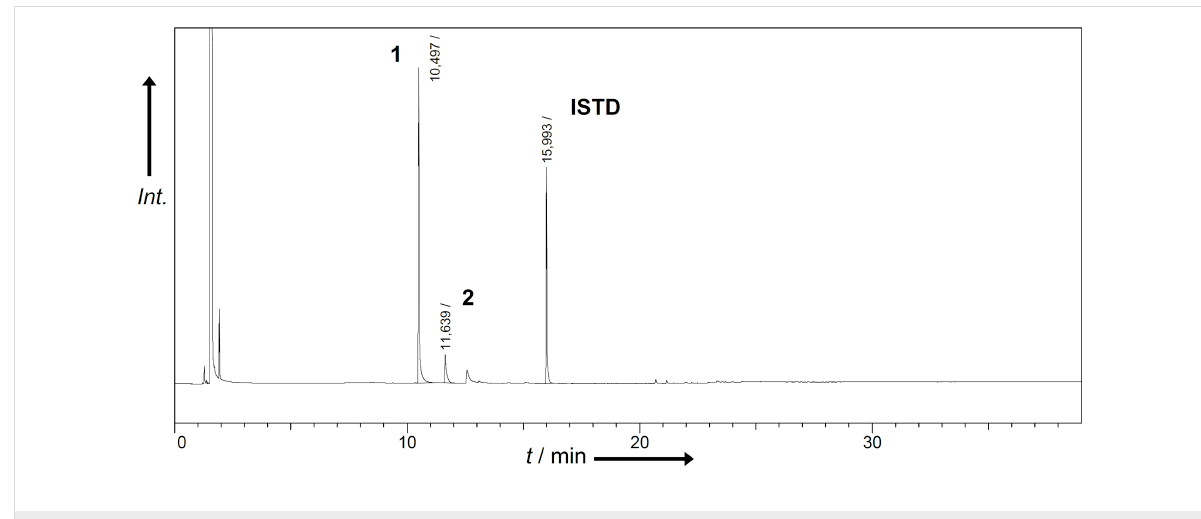
Figure 1: Crude product composition after electrochemical treatment of lignin at Ni-based electrodes by gaschromatography. Retention times: 10.50 min vanillin ( 1 ), 11.64 min acetovanillone ( 2 ), 16.00 min dodecylbenzene (ISTD).